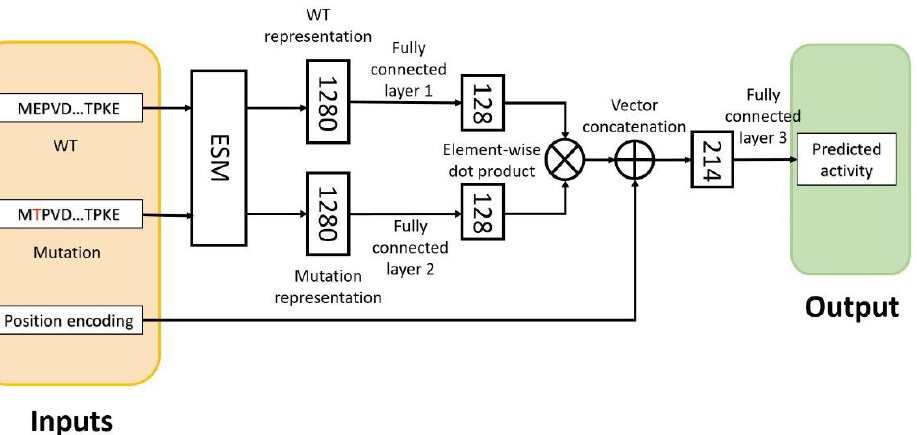
Figure 1. The generic architecture of the Rep2Mut model. Tat protein (86 amino acids) is shown as an example. An amino acid in red: a mutated residue; numbers in the rectangles indicate the size of the vectors; filled rectangles in brown: input; filled rectangles in green: output; cross symbol: elementwise dot product; plus symbol: concatenation of vectors.